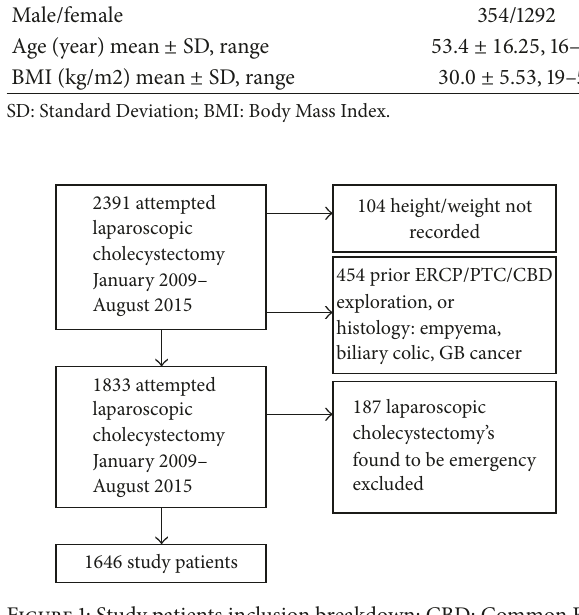
Figure 1: Study patients inclusion breakdown; CBD: Common Bile Duct; PTC: Percutaneous Transcutaneous Cholangiogram; ERCP: Endoscopic Retrograde Cholangiopancreatography.